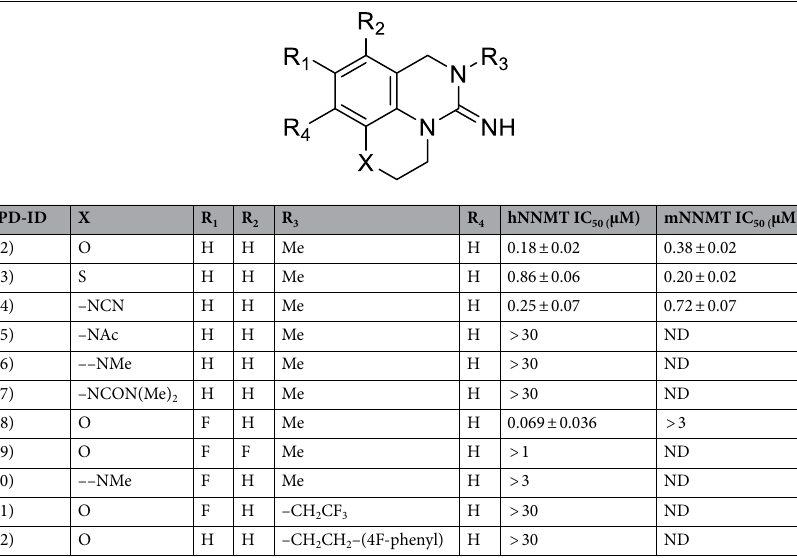
Table 2. Expansion of the SAR.